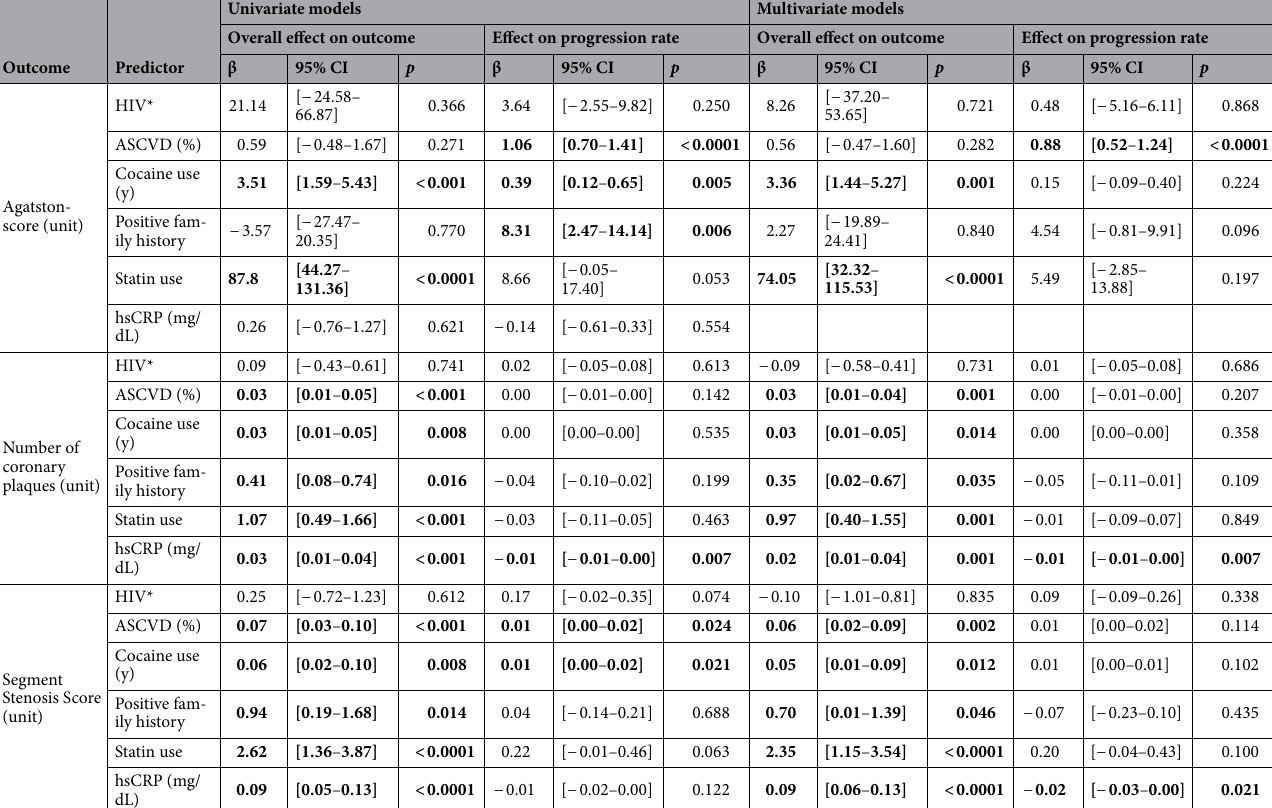
Table 2. Predictors of coronary artery disease outcomes among the total population. *: HIV was forced into the multivariate model. Abbreviations: β unstandardized beta coefficients from linear mixed model; ASCVD risk cardiovascular risk defined by the ACC/AHA Guideline on the Assessment of Cardiovascular Risk; CI confidence interval; HIV human immunodeficiency virus; hsCRP: high ‐ sensitivity C ‐ reactive protein. p values smaller than 0.05 are indicated in